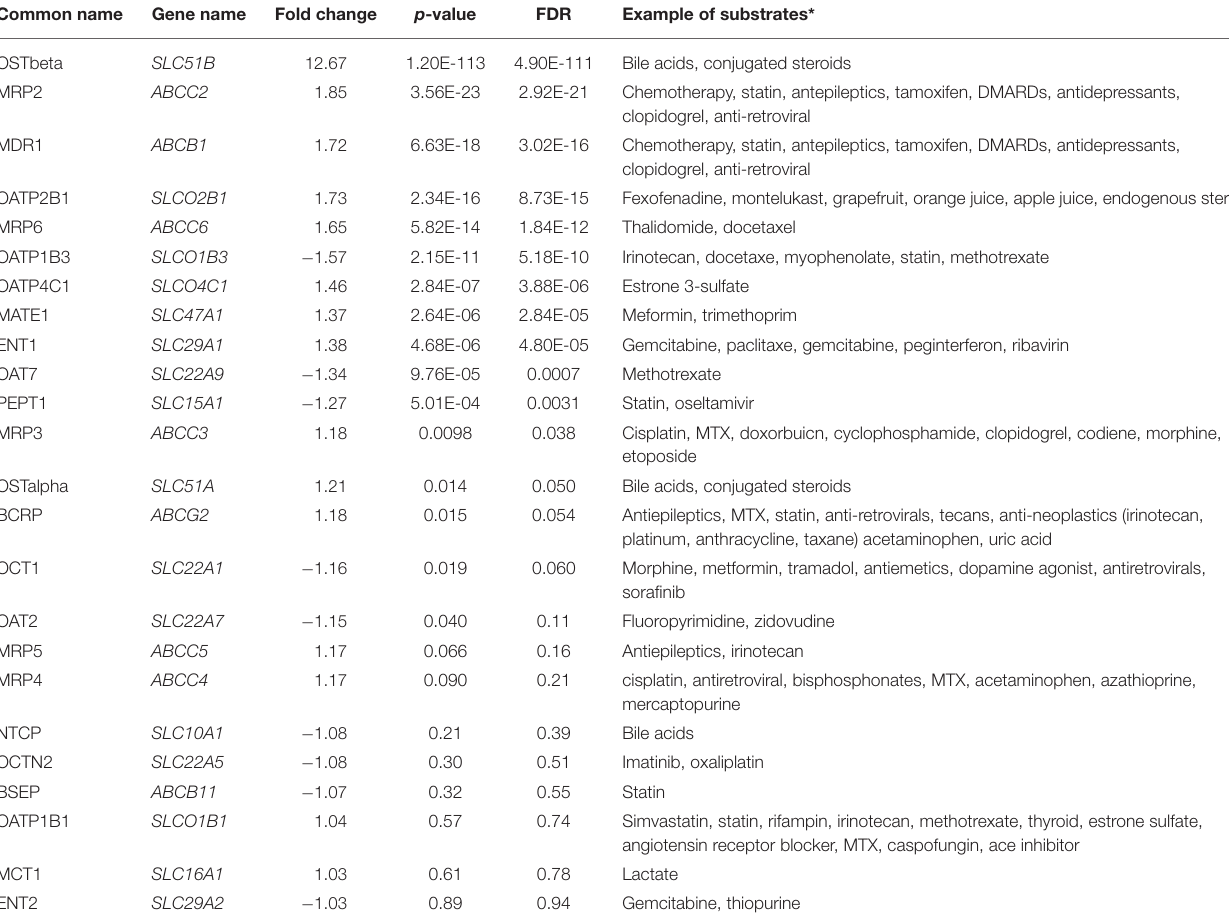
TABLE 2 | Rifampin-induced changes in gene expression of clinically relevant drug